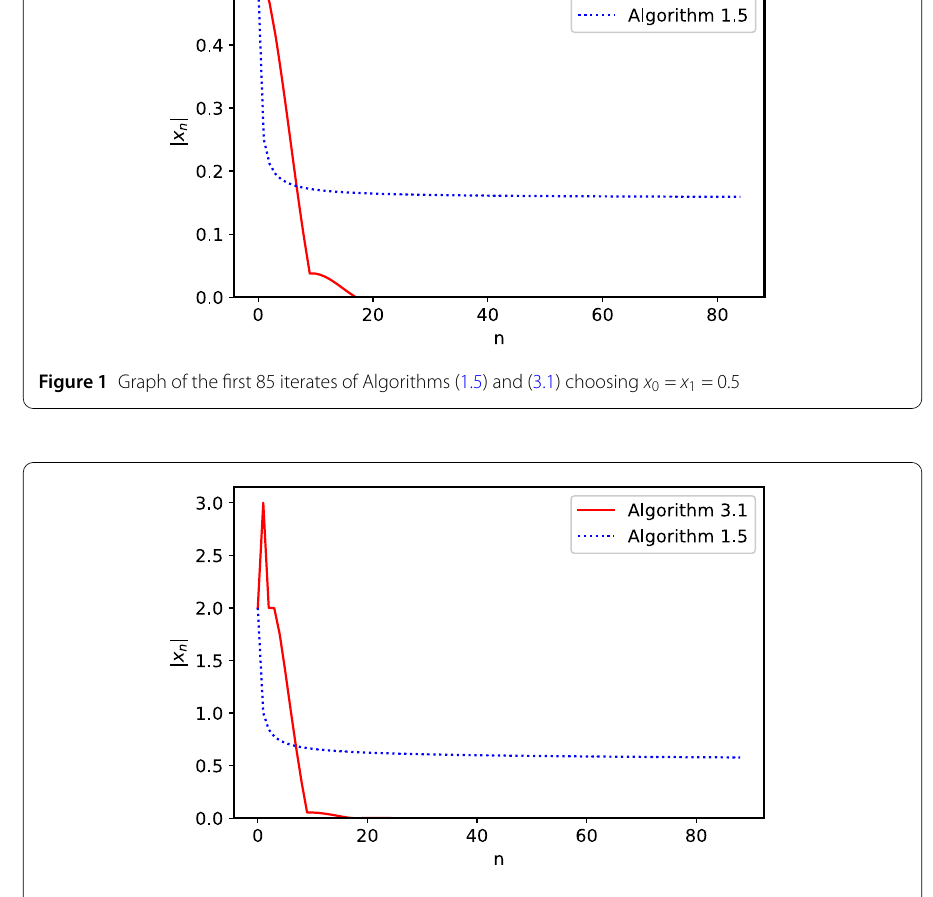
Next, we give an example to show that Algorithm (3.12) is